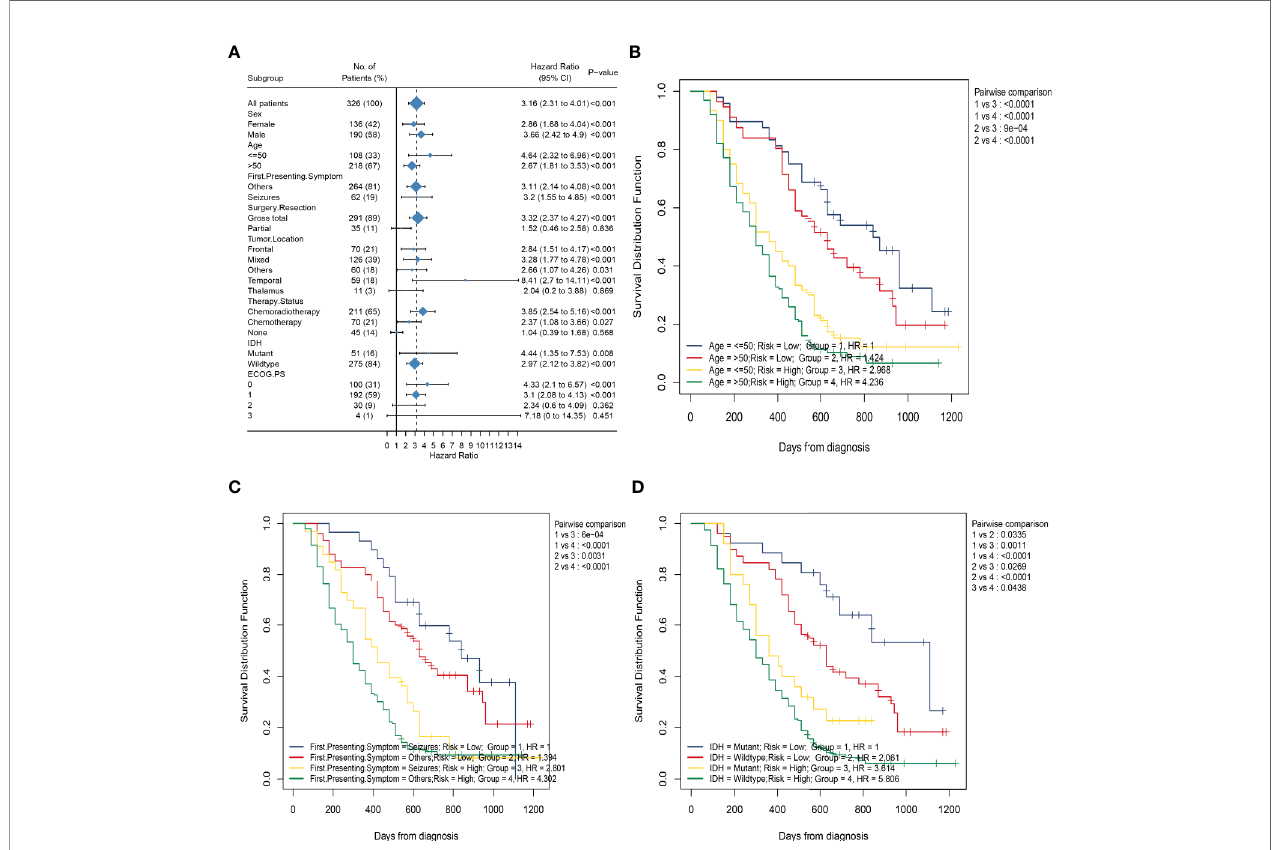
FIGURE 6 | Subgroup analysis based on clinical characteristics in the whole data. (A) Forest plots of the associations between HRS and overall survival in various subgroups; (B) Kaplan – Meier curves of overall survival for patients in subgroups strati fi ed by both HRS groups and age groups; (C) Kaplan – Meier curves of overall survival for patients in subgroups strati fi ed by both HRS groups and fi rst presenting symptom; (D) Kaplan – Meier curves of overall survival for patients in subgroups strati fi ed by both HRS groups and IDH mutation